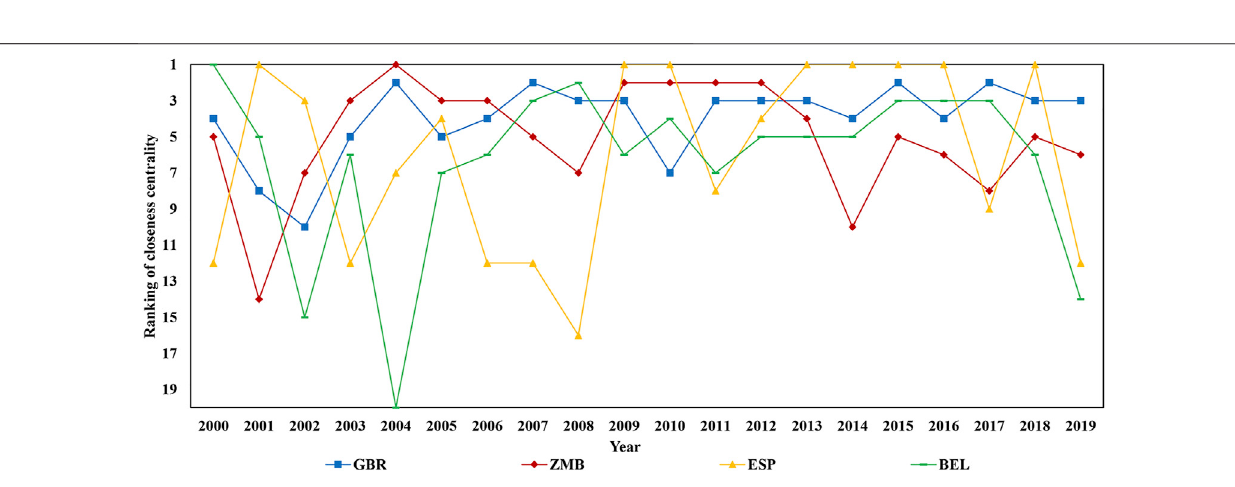
FIGURE 5 | The rankings of closeness centrality from 2000 to